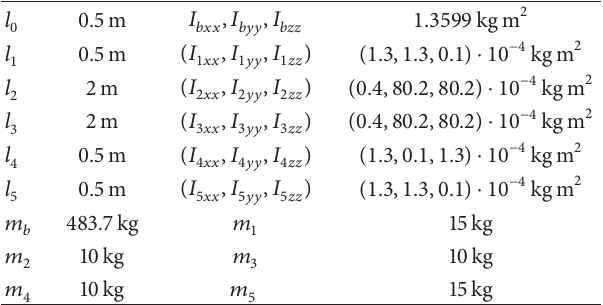
Table 2: The system parameters for